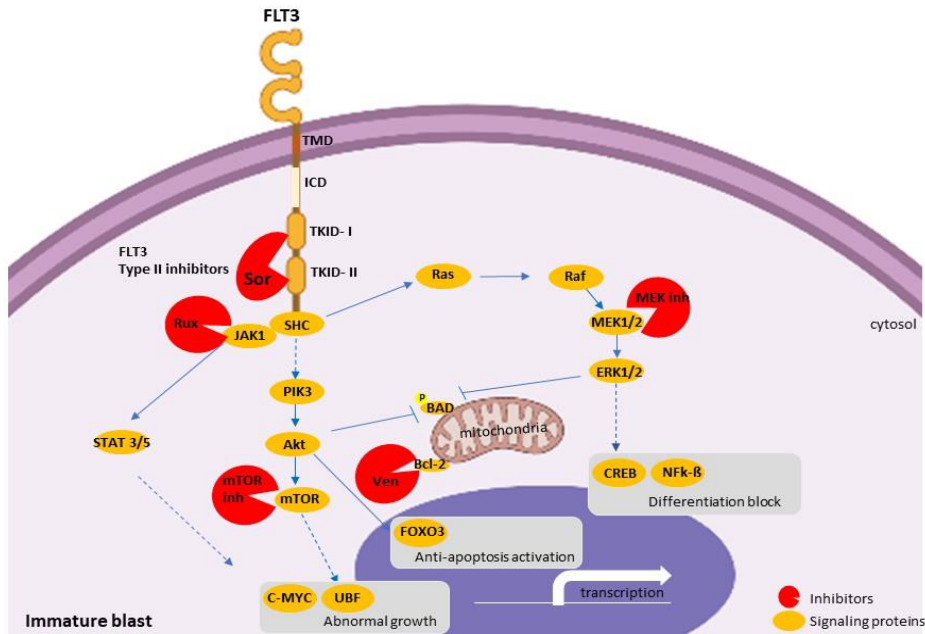
Figure 3. Schematic representation of the possible inhibitory points in the FLT3 signaling pathway. Type II FLT3 inhibitors such as sorafenib act in the inactivated FLT3 receptor (represented as an FLT3 monomer). Active FLT3 transduces signaling through (1) the Ras/Raf/MEK/ERK